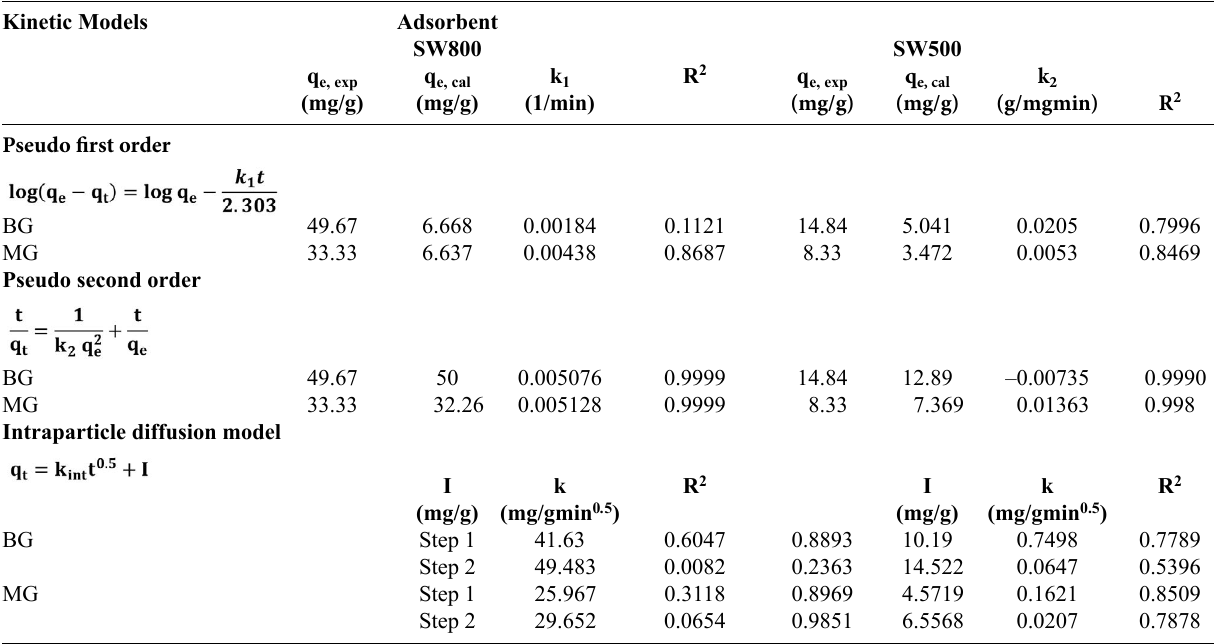
Table 3. The constants of the pseudo first-order, pseudo second-order kinetic models, and intraparticle kinetic model for BG and MG removal (n = 3). Kinetic